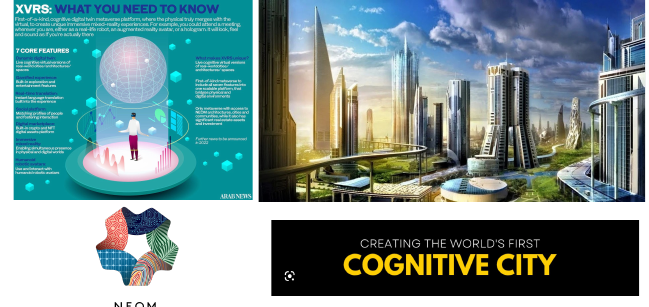
Figure 5: XVRS: Metaverse Cognitive City The Line, Saudi